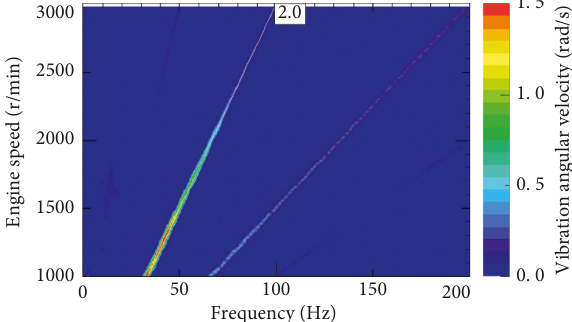
Figure 22: Engine flywheel torsional vibration angular velocity during